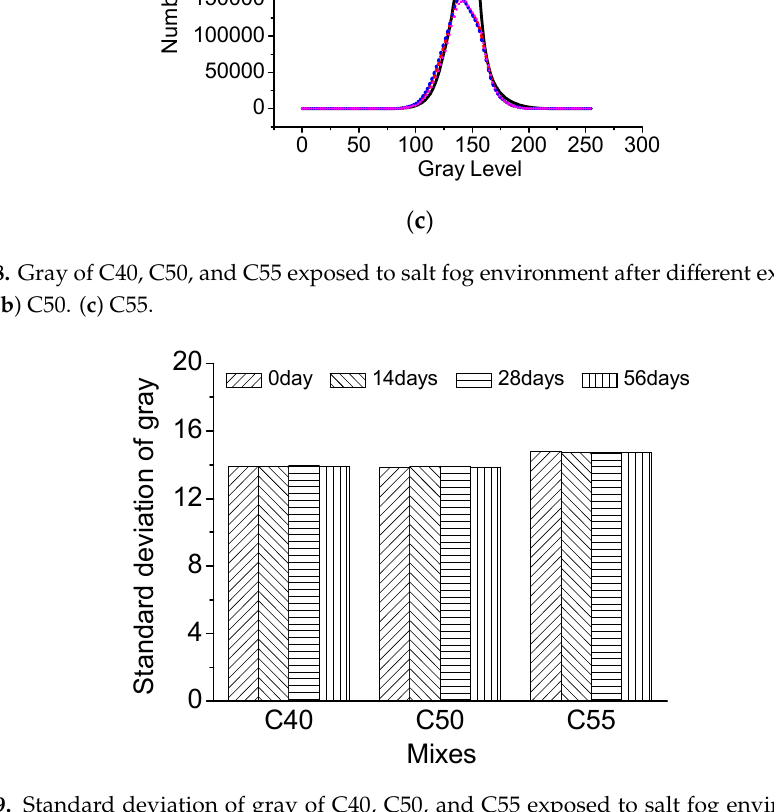
Figure 19. Standard deviation of gray of C40, C50, and C55 exposed to salt fog environment after different exposure times.